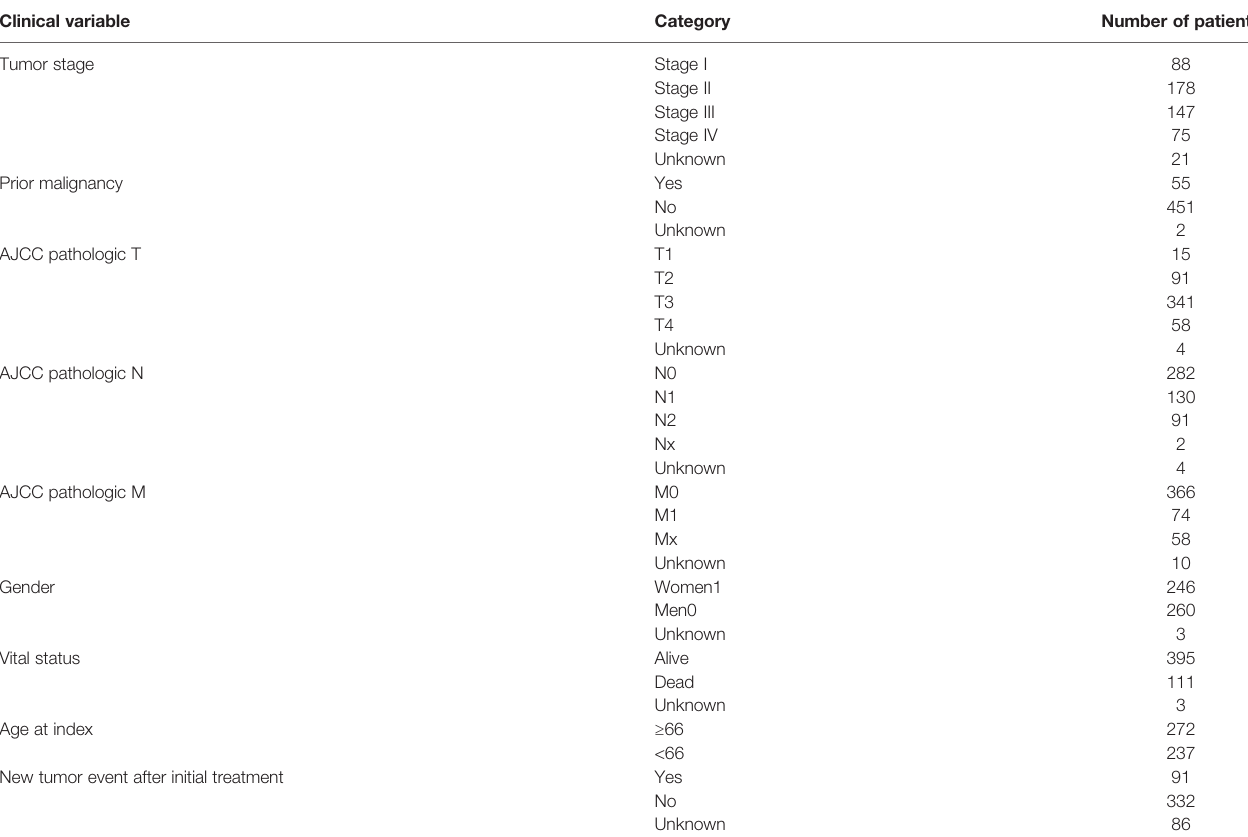
TABLE 1 | Clinical Information for TCGA Colorectal Cancer